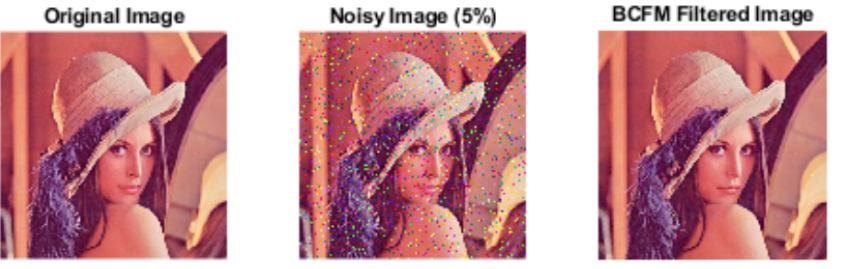
Figure 14. 1. Original Lenna image. 2. Noisy image after adding noise. 3. BCFM filtered image for n = 10 bootstrap